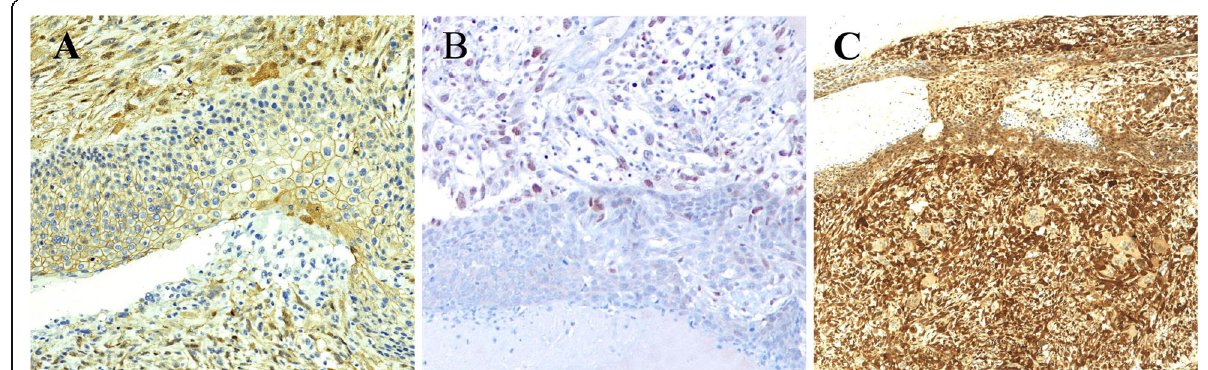
Fig. 3 Assessment of β -catenin, LEF-1 and P16. a : β -catenin showed normal type (membranous positive) in the carcinomatous component and abnormal type (cytoplasmic and/or nuclear positive) in the sarcomatous component (× 20). b : LEF-1 expression is obviously found in nuclei of sarcomatous components but very few in carcinomatous components (× 10). c : P16 yielded positive results in the cytoplasm and nuclei of both